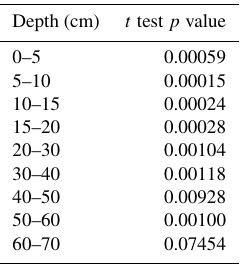
Table D2. We use p values from Student’s t test to compare, depth by depth, the TOC between vineyard and forest soils. This test is applicable if the variances are in the same order of magnitude. We therefore performed the test on log 10 (TOC) to have similar orders of magnitude of variances between vineyard and forest soils. The p value results are shown below.